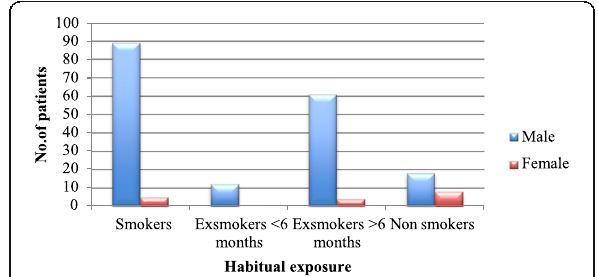
Fig. 8 Distribution of habitual exposure with gender